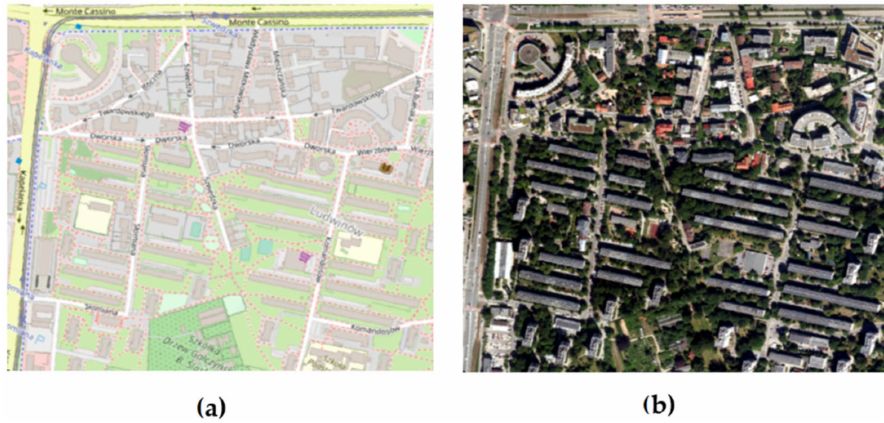
Figure 1. Study area: ( a ) OpenStreetMap, ( b ) orthophotomap.